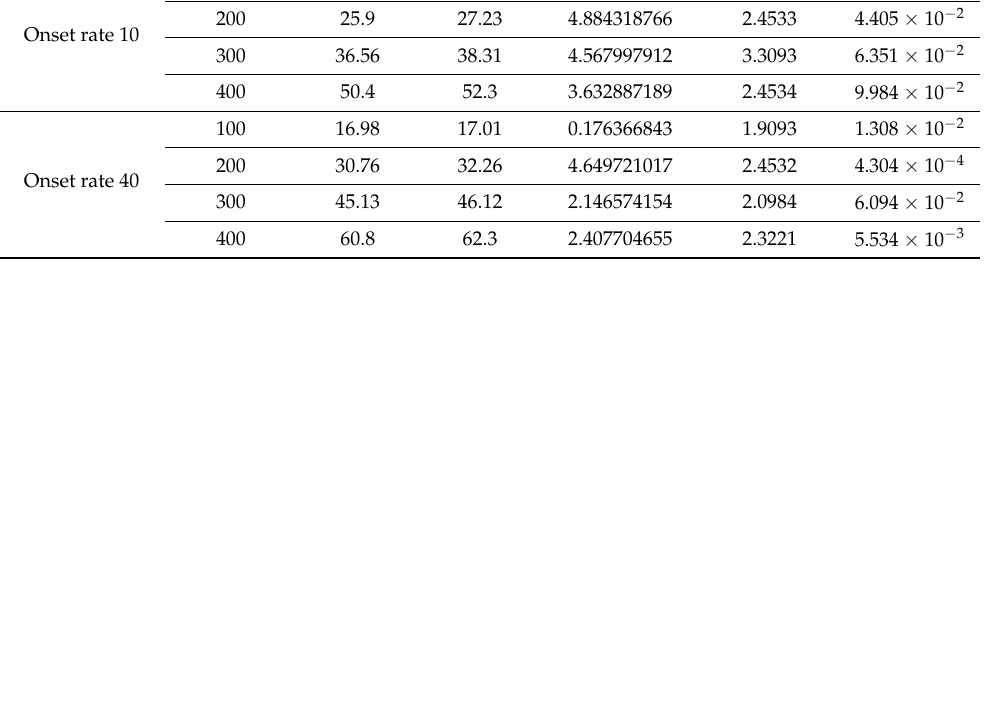
Table 4. t -Test for makespan between HWACO and QANA.